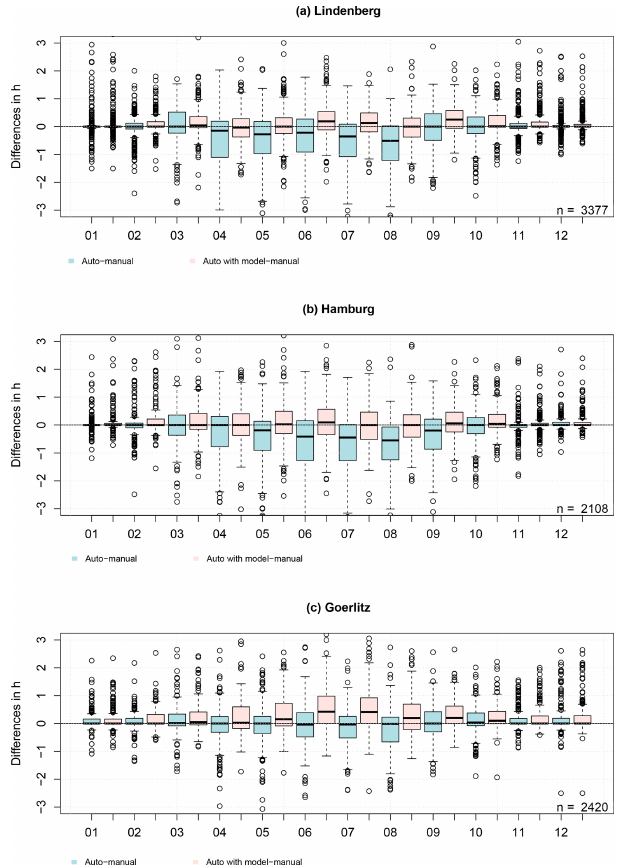
Figure 8. Boxplot of differences between automatic and manual measurements in hours for every month for the station Linden- berg (a) , Hamburg (b) and Görlitz (c) . Blue boxplots: raw data is used; pink boxplots:adjusted data is used.